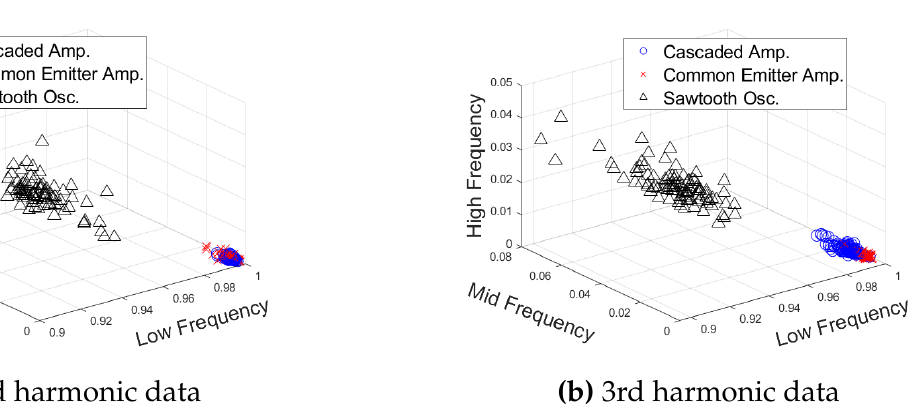
Figure 16. Fourier feature space representation of second and third harmonics data, SNR=14 dB.